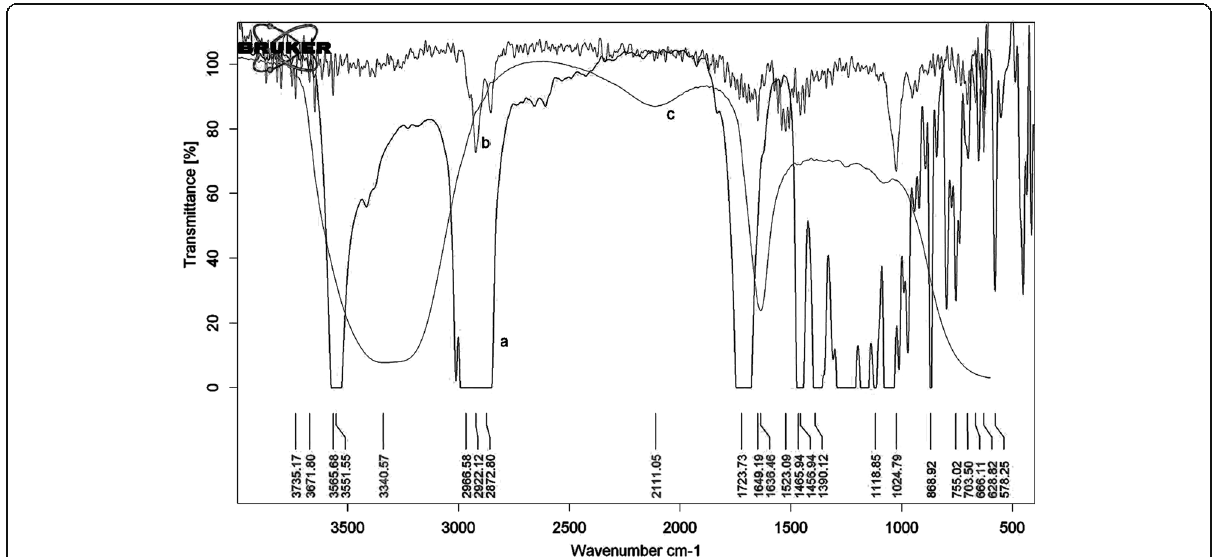
Fig. 1 FT-IR spectra. a Simvastatin. b Simvastatin nanostructured lipid carrier formulation. c Simvastatin nanostructured lipid carrier loaded transdermal